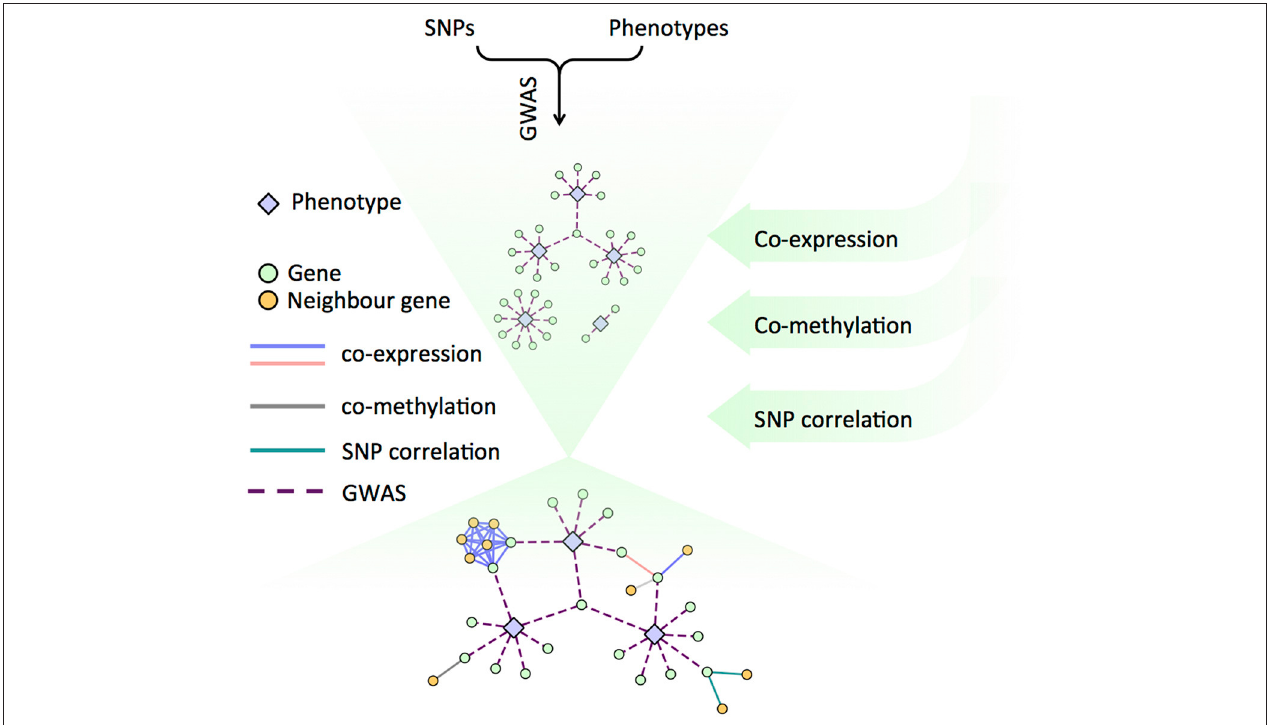
FIGURE 3 | Schematic of the Lines of Evidence scoring system (LOE scores) used to quantify the number of lines of evidence connecting genes to phenotypes.